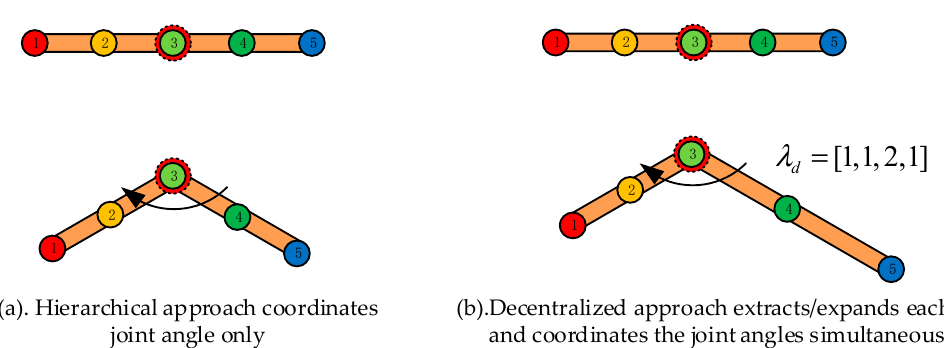
Figure 15. Reconfiguration ability of hierarchical and decentralized virtual linkage approach.